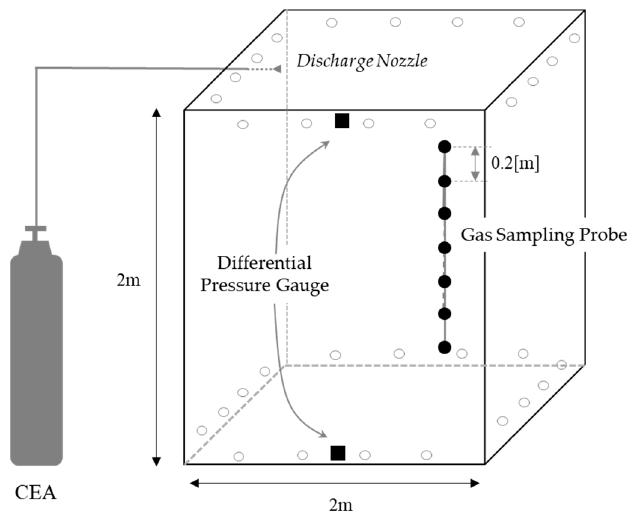
Figure 4. Schematic diagram of test enclosure used in the experiment.